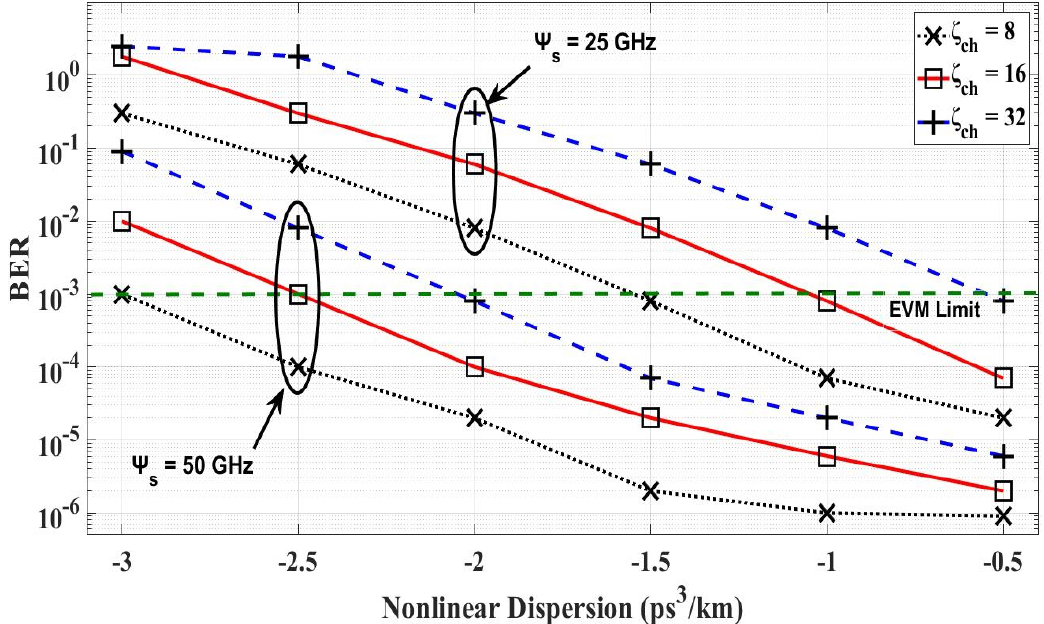
Figure 15. Nonlinear dispersion versus BER at 25 and 50 GHz channel spacing, 500 km transmission distance and 8, 16 and 32 number of channels.